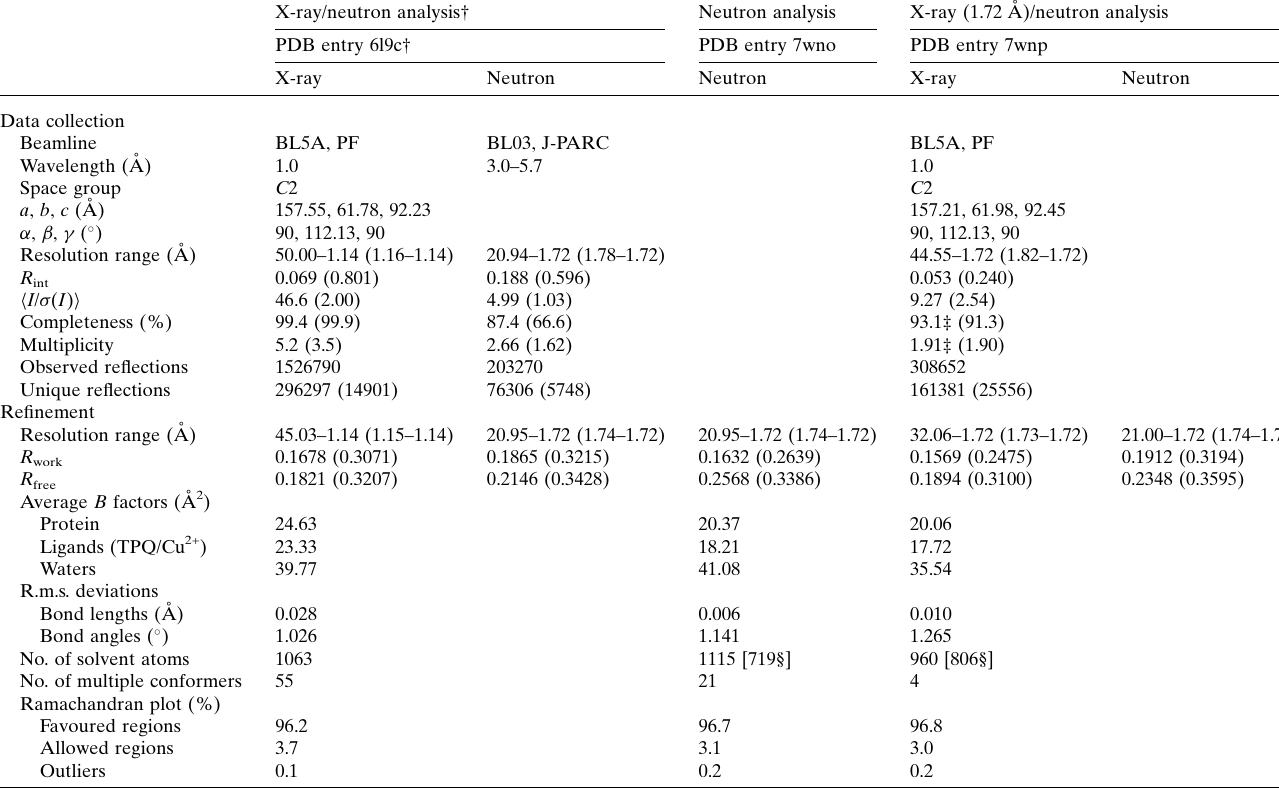
Table 1 Data-collection and refinement statistics. Values in parentheses are for the outer